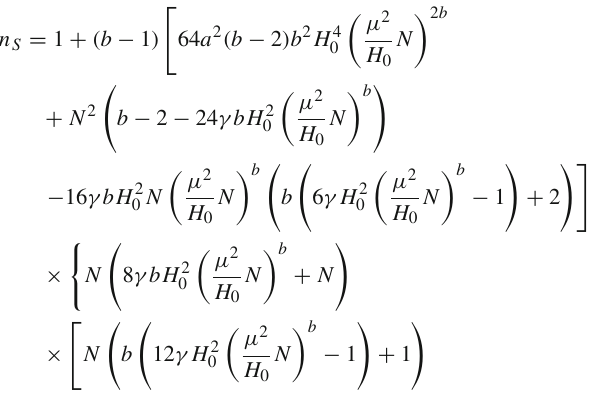
b = 3 . 78 when N = 50, or b = 4 . 136 for N = 60 for the same values, r ∈ [ 10 − 50 , 10 − 20 ] . In Fig. 1 we present the plots of the spectral index and of the tensor-to-scalar ratio as a function of b